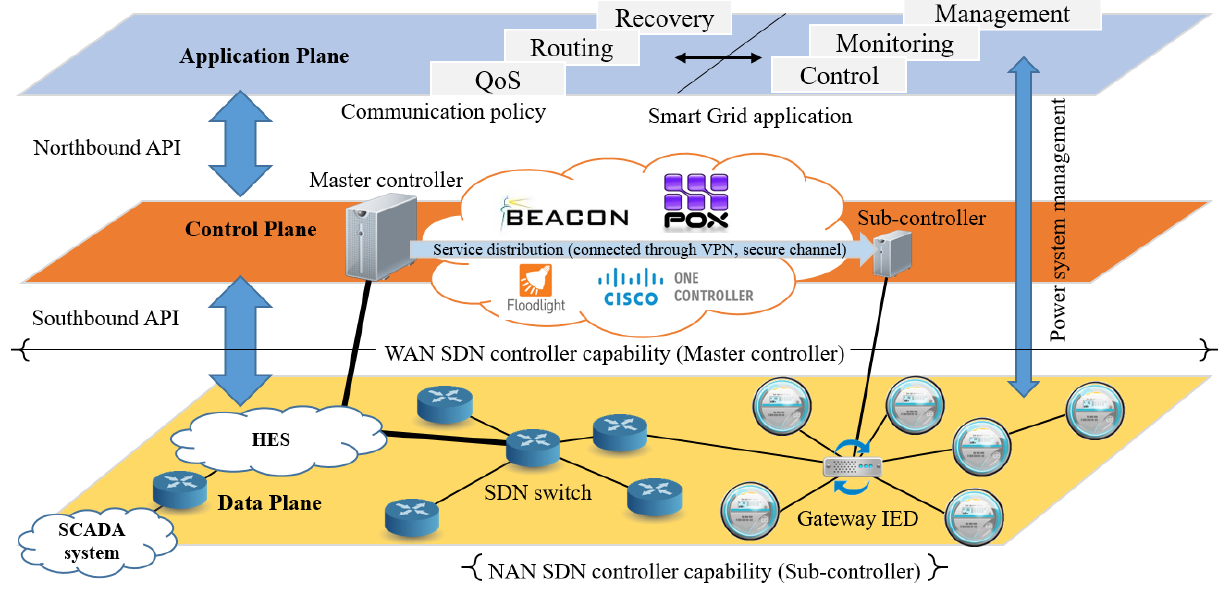
Figure 3. Illustration of the multi-controller-based SDN-enabled smart grid infrastructure.